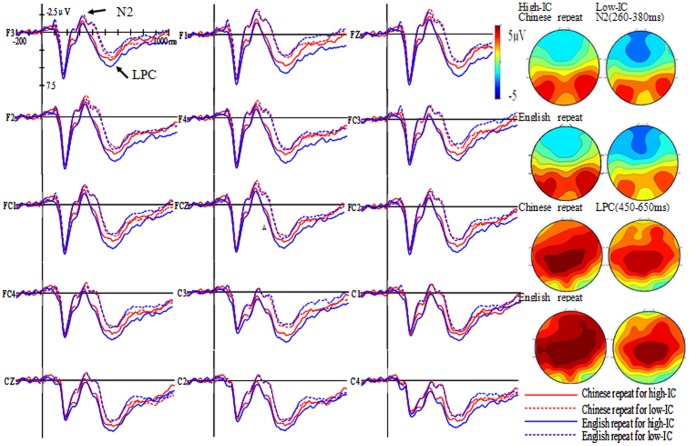
Grand average waveforms and topographic maps for L1 and L2 repeat trials for the high and low inhibitory control (IC) group.